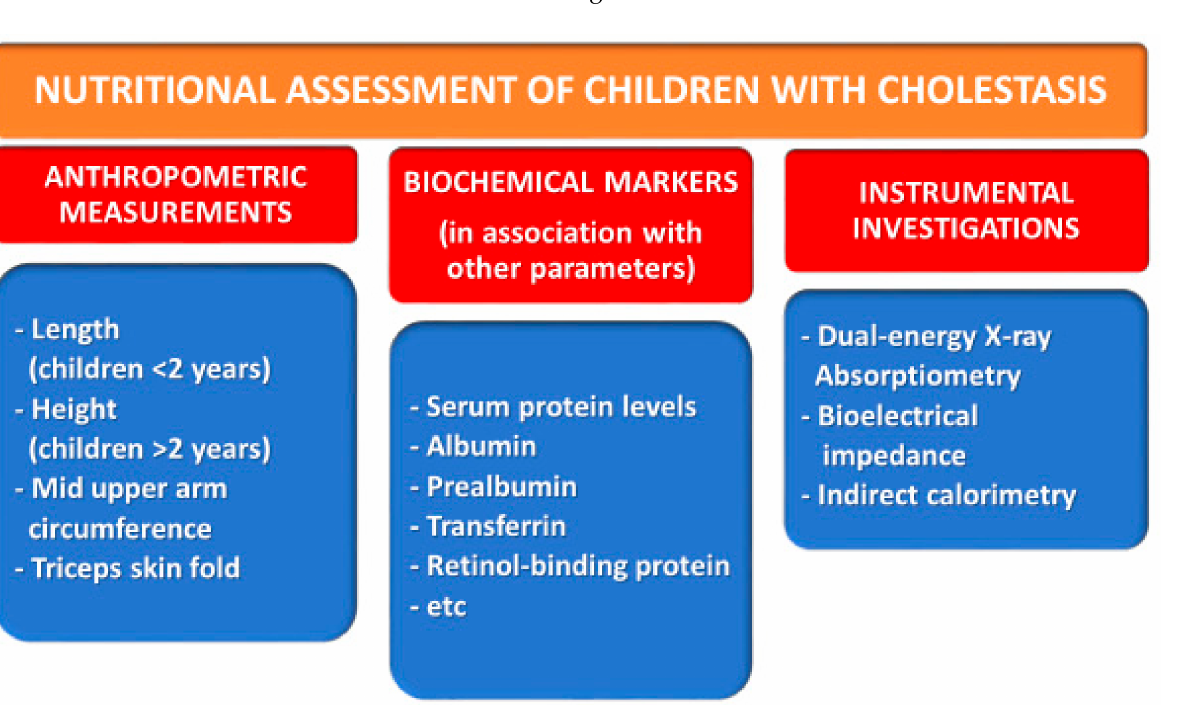
Figure 4. Nutritional assessment of pediatric chronic cholestatic liver